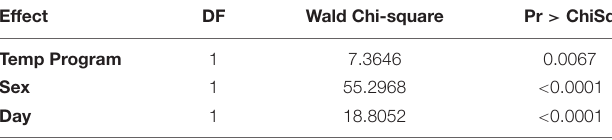
TABLE 3 | Type 3 analysis of effects for blueberry detectability over time.